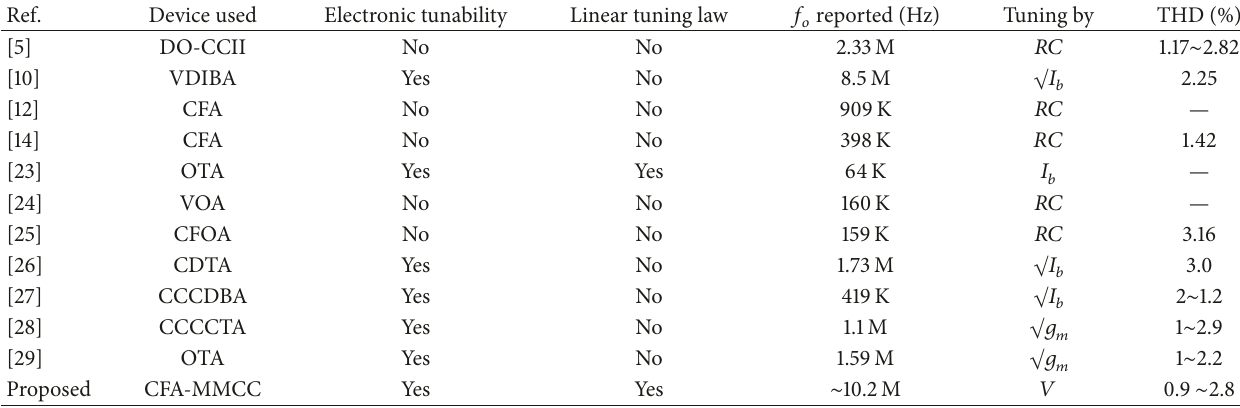
Table 2: Comparative description of recent QO designs.